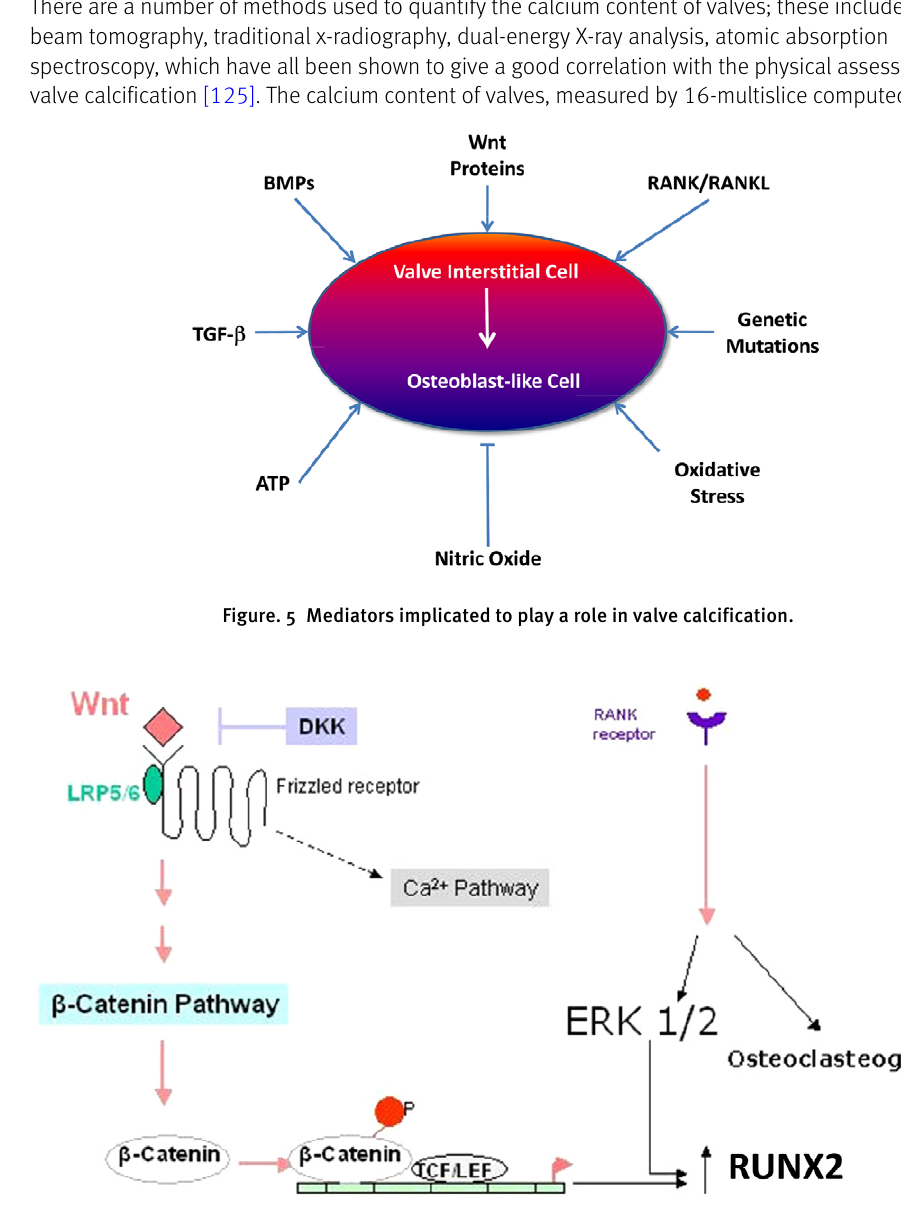
Figure. 6 Signalling pathways for Wnt proteins and RANK that lead to increased expression of